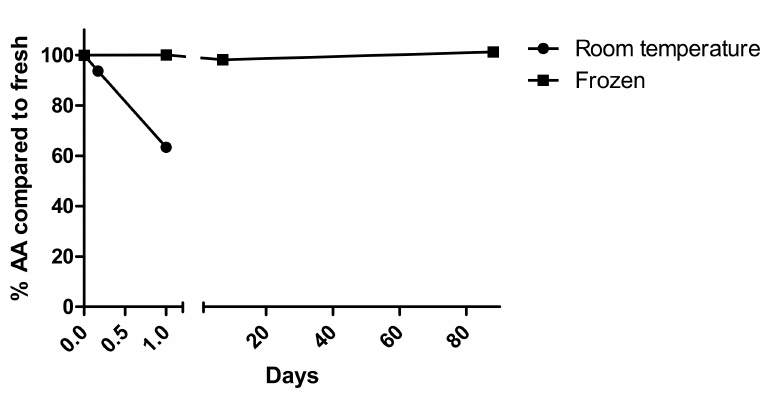
Figure 4. Stability of AA in blood sample stored at room temperature (mean of 3 samples) and of extracted AA in frozen at − 80 ◦ C (mean of 5